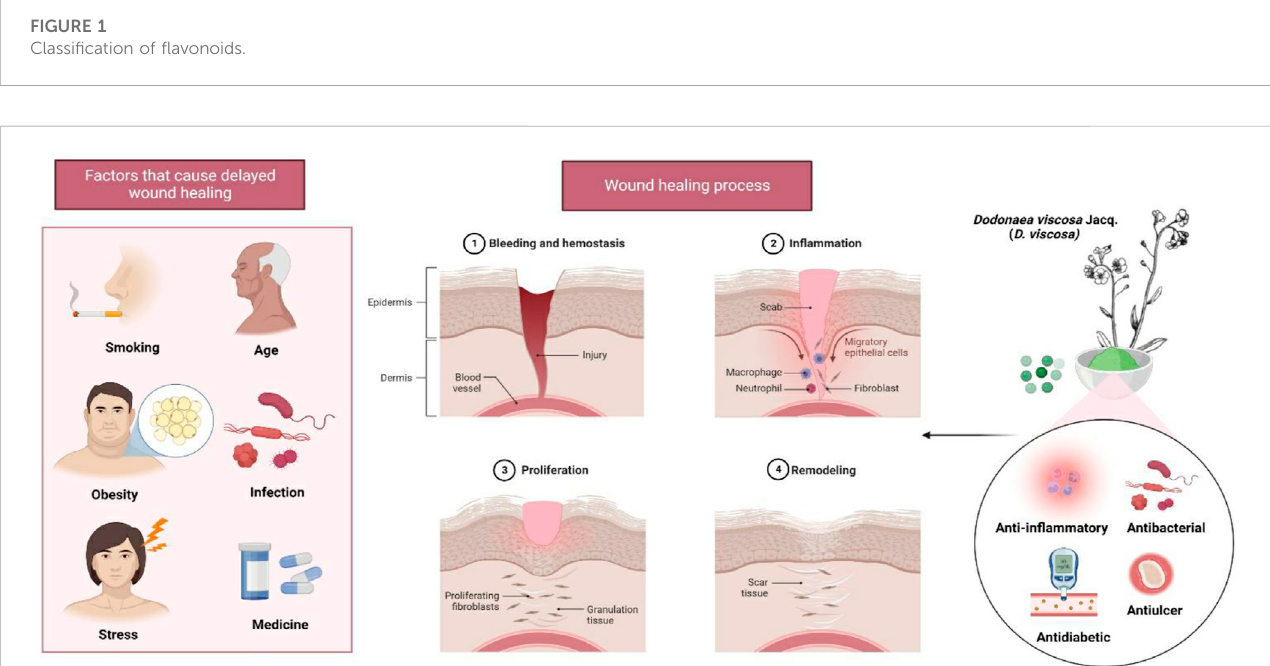
FIGURE 1 Classi fi cation of fl avonoids.